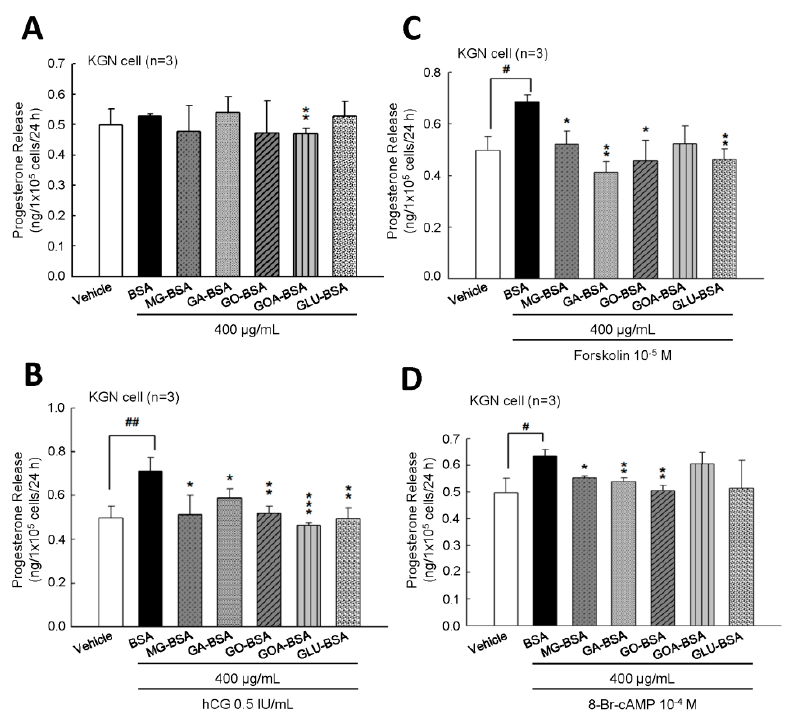
Figure 4. The inhibitory e ff ect of AGE products on the progesterone release from KGN cells. ( A ) After treatment of BSA (400 µ g / mL) as a control and AGE products (400 µ g / mL) for 24 h, the media were collected and then the level of progesterone was measured using ELISA. KGN cells were treated with AGE products in the presence of ( B ) hCG (0.5 IU / mL), ( C ) forskolin (10 − 5 M), and ( D ) 8-Br-cAMP (10 − 4 M) for 24 h. Data are shown as the mean ± SD ( n = 3). * p < 0.05, ** p < 0.01 compared with the control group; # p < 0.05, ## p < 0.01 compared with the vehicle group.